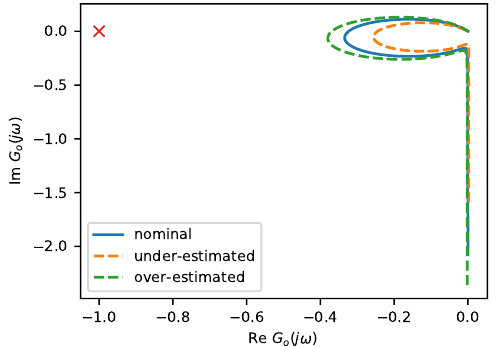
Figure 2. The Nyquist plots for various PI controller gains. The first analysis is presented for cases with under/overestimated α a and adaptation turned on/off. The aim of this analysis was to show the advantage of the adaptive system. The parameters of the robust adaptive controller were set to R 0 = 100 and g 0 = 1.0 10 − 5 . The simulation results are visible in Figure 3. At the beginning of the × adaptation process shown in Figure 3a,b, the reference error e r is large for all cases. There is also a difference visible between the under/overestimate α a . At the end of the adaptation process shown in Figure 3c,d, the reference error is much lower than for the static PI controller. The PI controller with adaptation has a reference error much lower than that of the static alternative. The improvement of control system behavior is also visible in the performance indexes which are given in Table 1. The performance improvement of the adaptive PI controller was at least 40% compared to the static alternative.